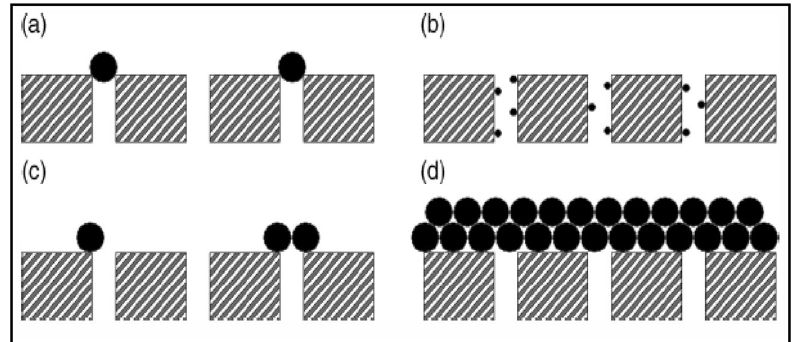
Figure 1. The various types of membrane fouling ( a ) complete pore blocking, ( b ) internal pore blocking, ( c ) partial pore blocking, and ( d ) cake formation after Field 33